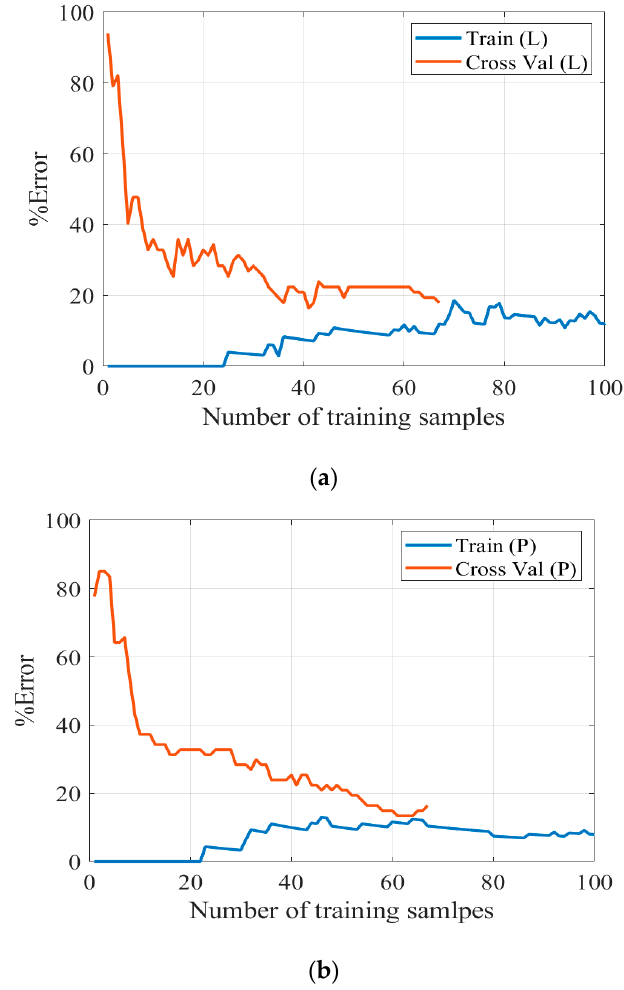
Figure 4. Learning curve for logistic regression (L: linear, P: polynomial) ( a ) Linear combination of features; ( b ) Polynomial combination of features (p=8). Table 8. Error corresponding to different polynomial orders.